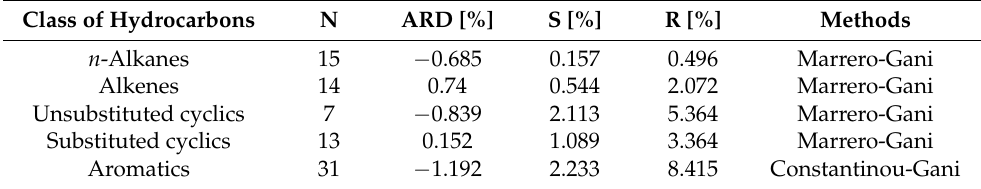
Table 6. Selected methods to predict the critical temperature (T c ) of hydrocarbons classes ( n -alkanes, alkenes, unsubstituted cyclics, substituted cyclics, and aromatics), of all the compounds present in OLP, obtained by thermal catalytic cracking of palm oil at 450 ◦ C, 1.0 atmosphere, with 10% (wt.) Na 2 CO 3 [17].